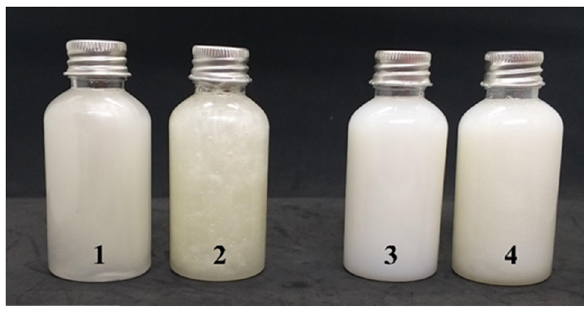
Figure 3: Initial ( 1 ) and 1 - month body wash product ( 2 ) ; initial ( 3 ) and 1 - month shampoo product ( 4 ) .